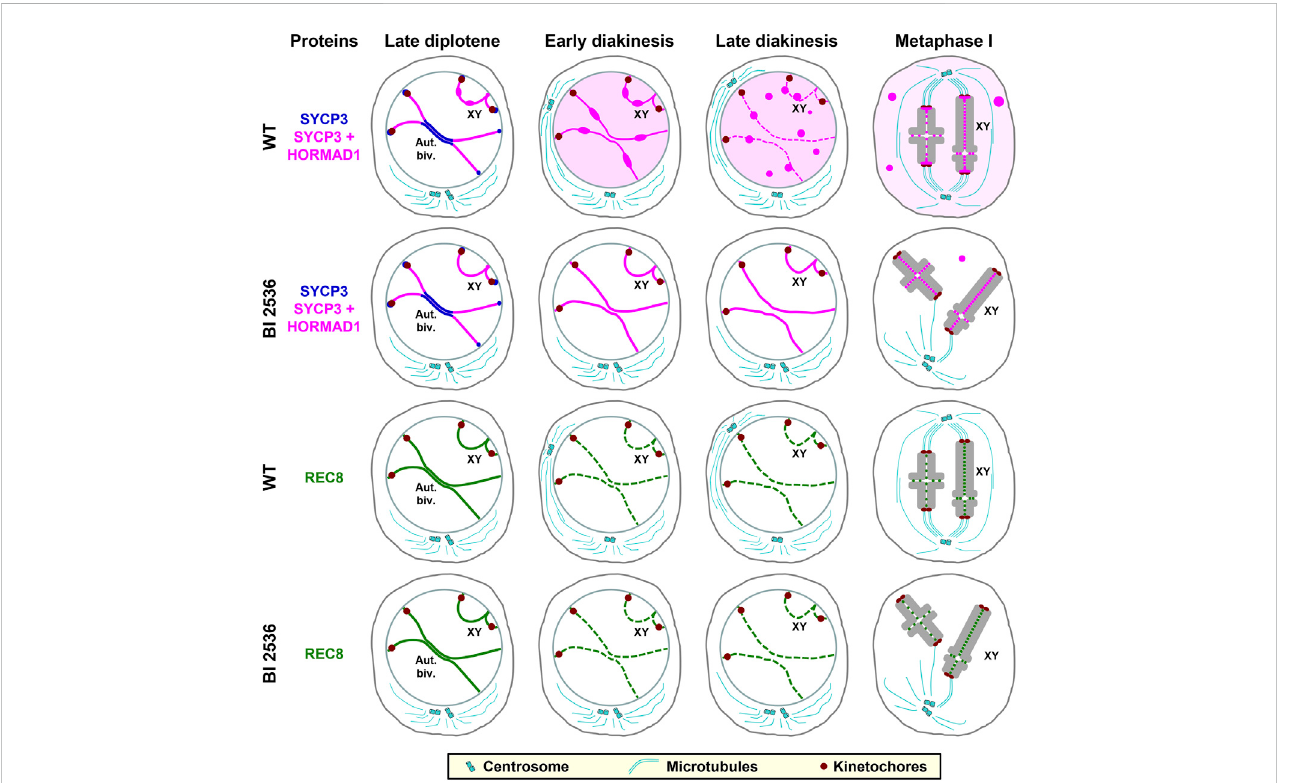
FIGURE 10 Schematic representation of the distribution of SYCP3, HORMAD1 and REC8 in WT and BI 2536-treated late diplotene, early and late diakinesis, and metaphaseIspermatocytes.Forclarity,asingleautosomalbivalent(Aut.Biv.)andthesexbivalent(XY)arerepresented.SYCP3isindicatedinblue,themergeof SYCP3andHORMAD1inpink,andREC8ingreen.BulgesandroundthickeningsalongdesynapsedLEs,aswellasnucleoplasmicorcytoplasmicagglomerates of SYCP3 and HORMAD1, are indicated. A nucleoplasmic and cytoplasmicbackgroundof SYCP3 and HORMAD1 are indicated as a palepink background in WT late diakinesis and metaphase I spermatocytes. Kinetochore regions are shown in brown, and centrioles and microtubules in light blue. The condensed chromatin of the autosomal bivalent, with a single interstitial chiasma, and of the sex bivalent (XY), with a distal chiasma, is shown in light grey in metaphase I